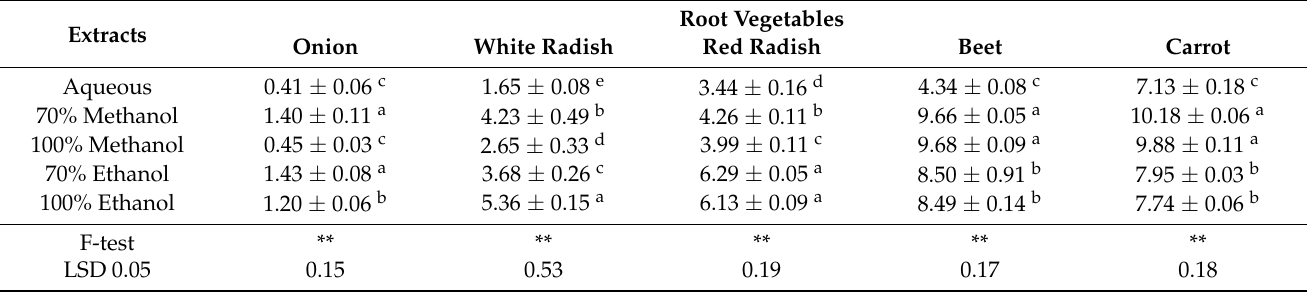
Table 2. The ferric reducing power (mg AAE/g) of the aerial part of selected root vegetables. Root Vegetables